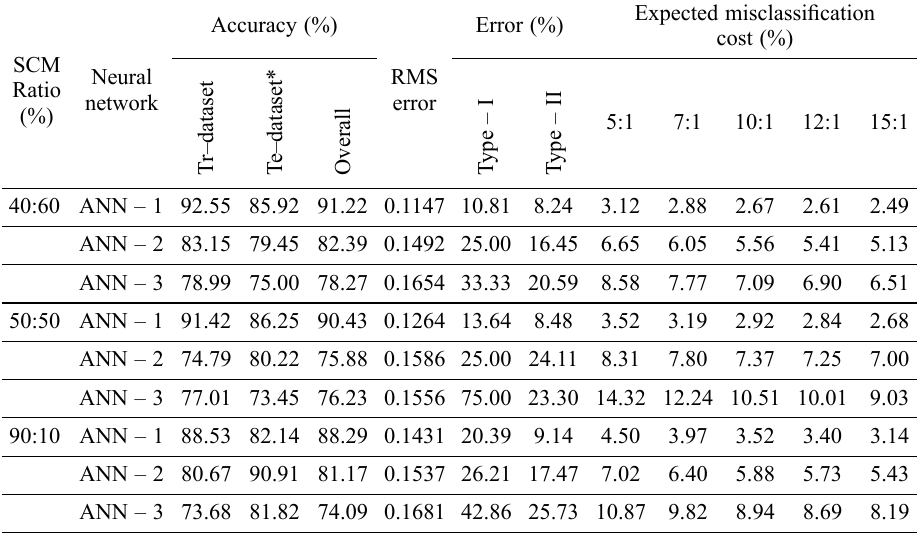
Table 7. Performance obtained by the SPSS credit modeling database